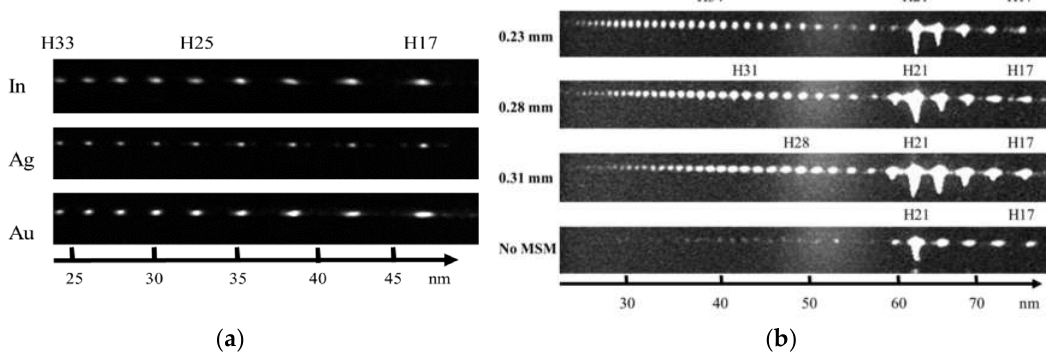
Figure 2. Raw images of harmonic spectra from ( a ) extended homogeneous (top to bottom) indium, silver and gold laser-produced plasmas (LPPs) pumped by 810 nm, 50 fs pulses and ( b ) multi-jet indium LPP produced using tilted MSM with the single plasma jet sizes of (top to bottom) 0.23, 0.28, and 0.31 mm pumped by two-color NIR + visible (1320 nm + 660 nm), 70 fs pulses. The peak intensities of 800 and 1320 nm pumps in the plasma area were 5 × 10 14 and 1.4 × 10 14 W cm − 2 , respectively, while the intensity of the second harmonic of 1320 nm pump was ~1 × 10 13 W cm − 2 . Maximally enhanced harmonics (H34, H31, and H28) are clearly distinguished for each of these plasma configurations. Bottom spectrum corresponds to the HHG from the homogeneous extended indium plasma produced at similar conditions.